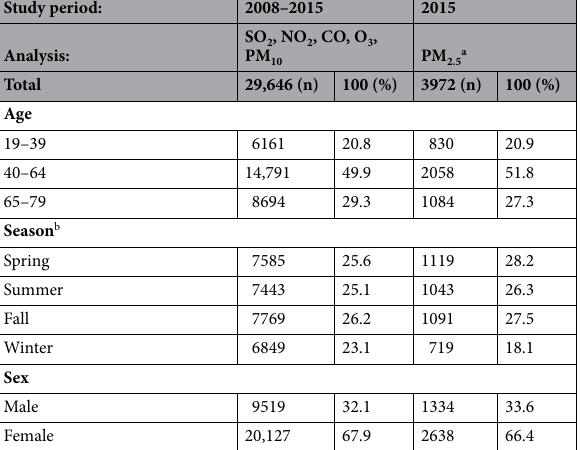
Analysis according to subgroups and potential effect modifiers. Figure 2 shows subgroup-specific estimated effects according to three age subgroups, sex, four seasons (spring, summer, fall, and winter), and urbanization of residence (urban or rural). Among the age subgroups, the correlation between air pollution and Meniere’s disease risk was strongest at the age of 40–64, especially for NO 2 , SO 2 , and CO. O 3 showed a gener- ally negative correlation in all age subgroups, and PM 10 and PM 2.5 showed no significant correlation in any age subgroup. Statistically significant results at lag0 were as follows: SO 2 : 1.05 (95% CI 1.01, 1.09) at age 40–64; NO 2 :